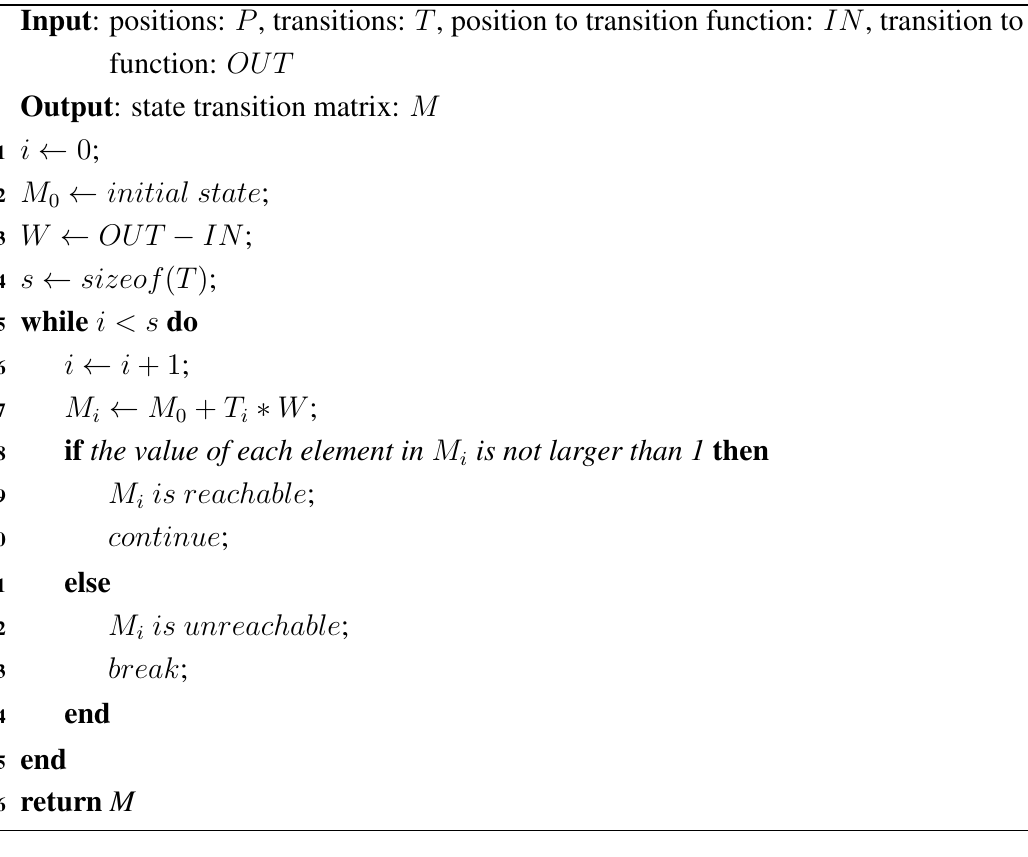
Algorithm 1 : Security and reachability test